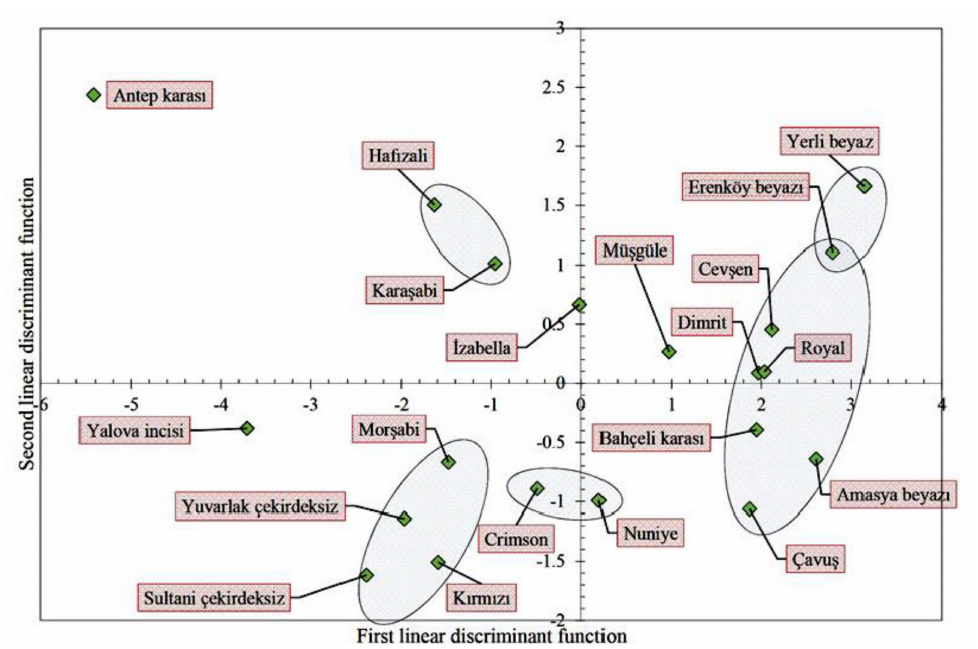
Figure 6. Biplot charts from linear discriminant analysis of 20 grape cultivars based on two principal component morphology variables derived from Elliptic Fourier data of 800 fruit outlines. (The locations of the cultivars on the chart show their own group centroid.)